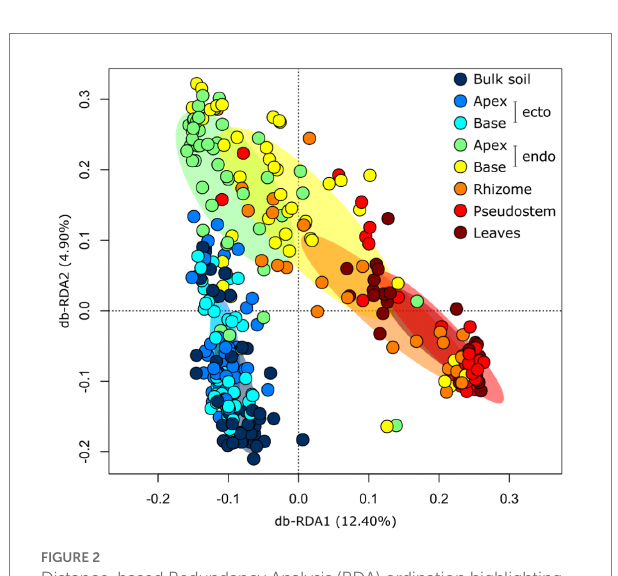
FIGURE 2 Distance-based Redundancy Analysis (RDA) ordination highlighting differences in the composition of fungal communities (Hellinger transformed OTUs) associated with Musa (AAA Group, Cavendish Subgroup) ‘Williams’ in various plant compartments. The ellipses represent standard deviations of the group centroids. endo, endorhizosphere; ecto,